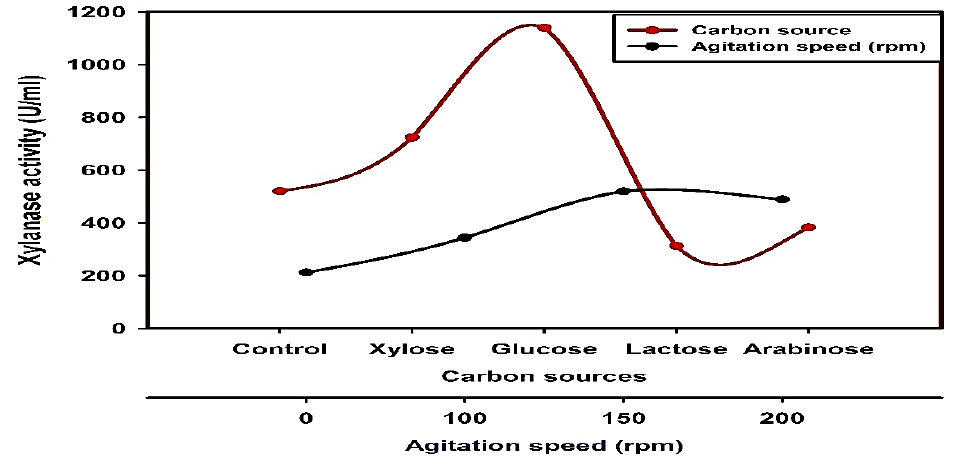
Figure 5. Comparing the effect of using different carbon sources and agitation speeds on xylanase production by Trichoderma harzianum kj831197.1.